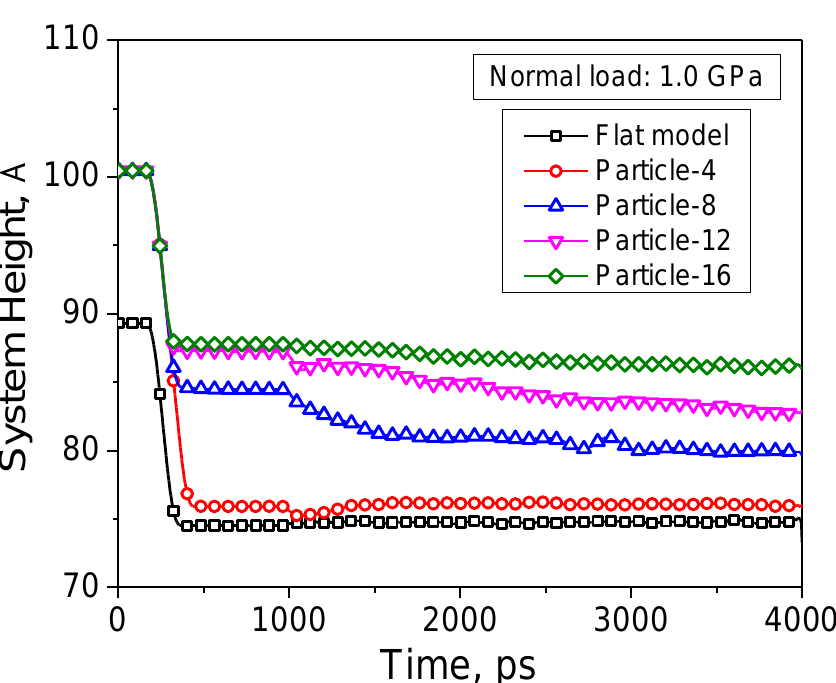
Figure 8. Comparison of the evolution of system heights against the simulation time between the flat model and particle models containing 4, 8, 12 and 16 nanoparticles.